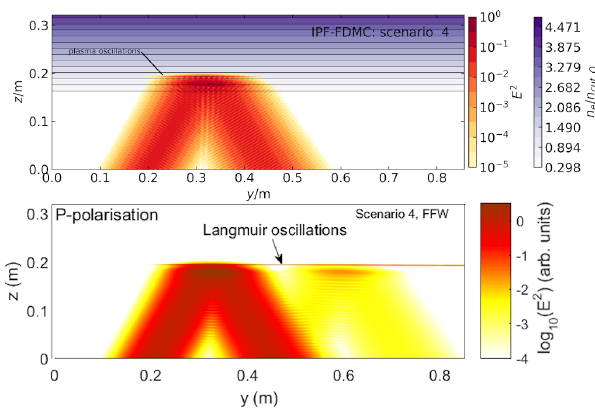
Figure 3. Di ff erence of the detector antenna signals obtained from the full-wave simulations for scenario #2.